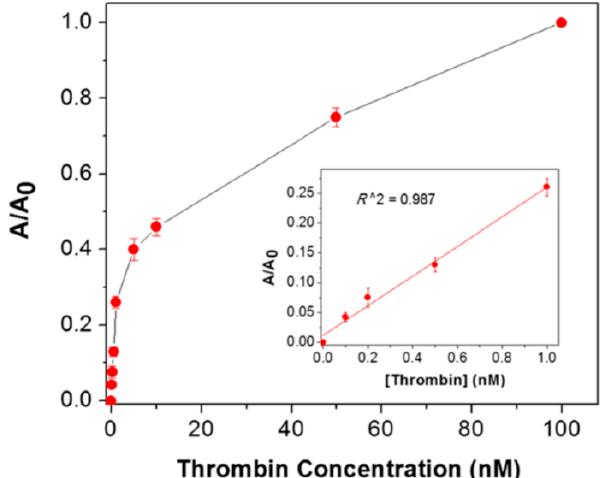
Figure 9. Correlations between the area ratio of the bright LC regions to the whole image and the concentration of thrombin. Inset: Linear relationship between the area ratio and the thrombin concentration. A = area of the bright LC regions. A 0 = area of the whole image. The error bars represent the standard deviation of four measurements of a sample for each assay. Reproduced with permission from Ref. [70]. (American Chemical Society).